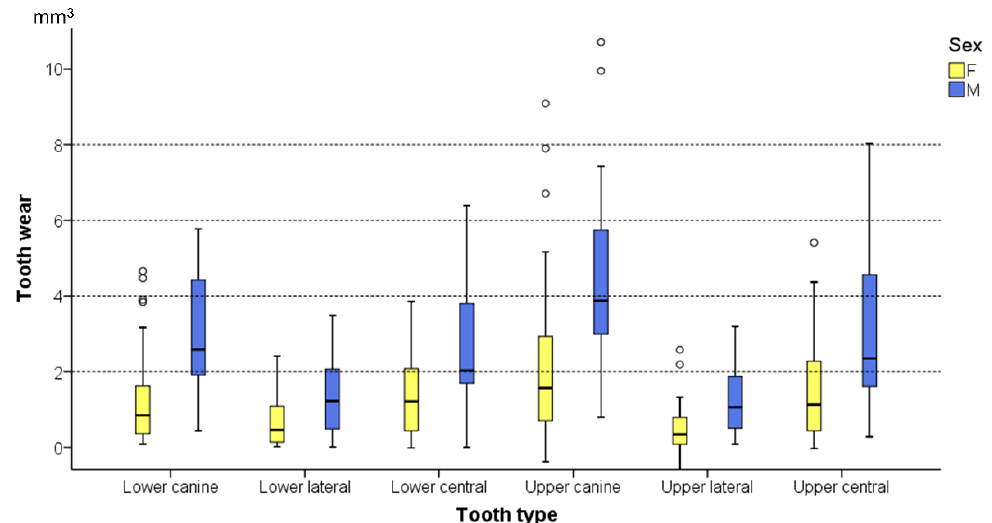
Figure 3. Box plots showing tooth wear for each tooth type and sex. The upper limit of the black line represents the maximum value, the lower limit the minimum value, the box the interquartile range, and the horizontal black line the median value. Outliers are shown as black circles (°).